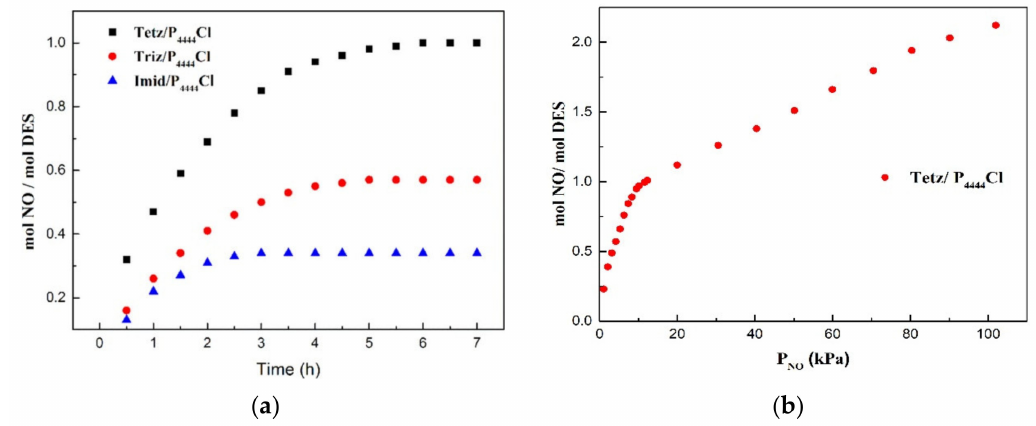
Figure 8. ( a ) NO absorption by P 4444 Cl-based DESs at 343.15 K and 101.3 kPa; ( b ) Effect of NO partial pressure on the NO capture of Tetz/P 4444 Cl DES at 303.15 K (Reprinted with permission from Ref. [88]. Copyright (2019) American Chemical